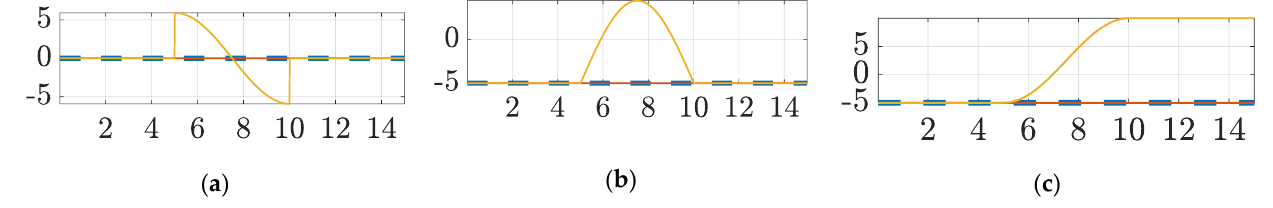
Figure 3. Optimal Trajectories from Pontryagin’s Method with time in seconds on the abscissas. ( a ) angular acceleration ω̇ (t) on the ordinate, ( b ) angular velocity ω(t) on the ordinate, ( c ) angular displacement θ(t) on the ordinate. Note the similarity in the ( c ) to Figure 2a.